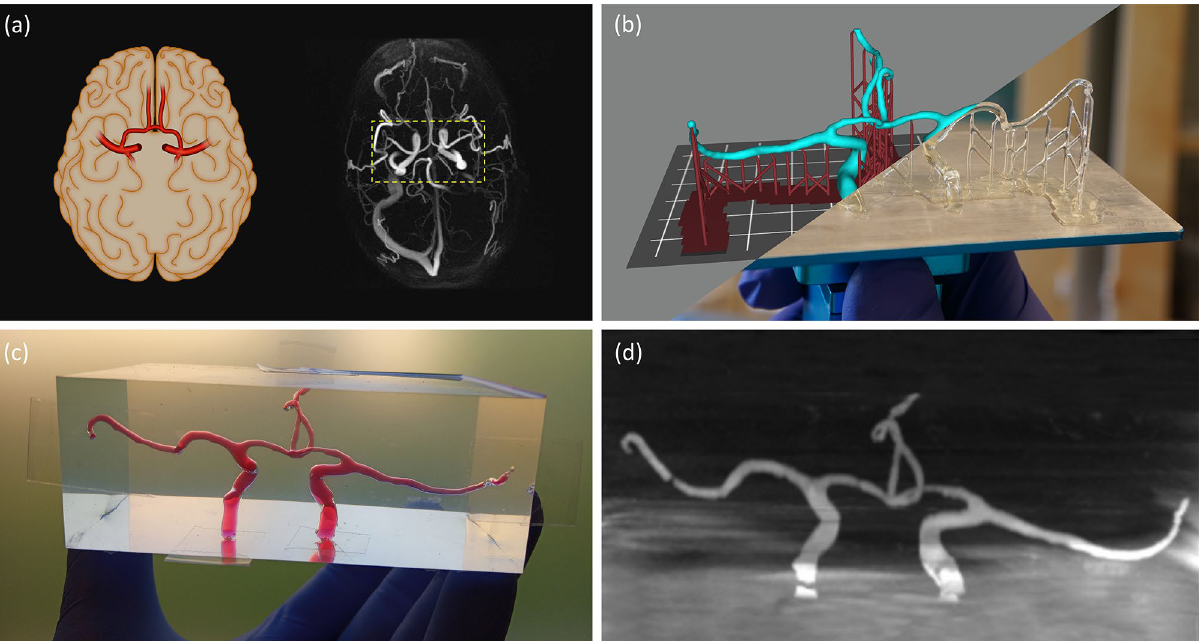
Figure 1. We recreated the anterior part of the cerebral arterial network as a full-scale phantom flow model in PDMS. This process consists of ( a ) creating a 3D model of the circle of Willis of a patient using CTA scanning techniques, ( b ) slicing and 3D printing a sacrificial mold using water-soluble resin, ( c ) casting PDMS around the scaffold before dissolving it, and ( d ) evaluating the flow channels using MRI. In panel ( a ), we illustrate the internal carotid, anterior and middle cerebral arteries and their position in the human brain (left), as well as show a maximum intensity projection from the 4D flow MRI angiogram of the patient (right) 28 , both as axial views. Panel ( b ) shows overlapping images of the arterial network after it has completed slicing (upper left) and printing (lower right), along with the temporary support structure. In panel ( c ), the finished PDMS model can be seen filled with a blood like substance (water and food dye) and with tape covering the channel-ends. An illusion of air bubbles can be seen and this is caused by total internal reflection for extreme angles. Finally, panel ( d ) show an MRI scan (coronal view) of our phantom model, before it is mapped in 3D and compared with the original model. In this case, some small air bubbles where actually present and these resemble channel restrictions in the MRI